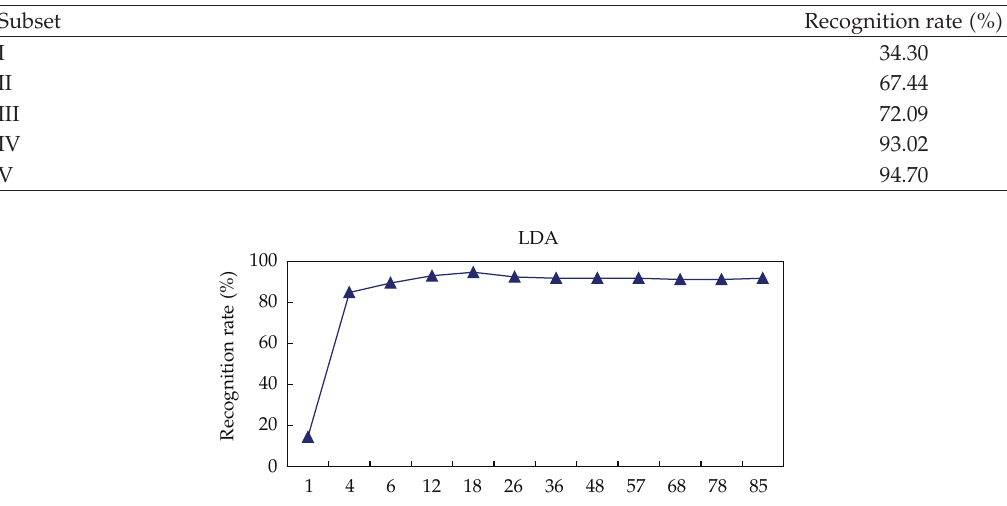
Table 3: Experimental results of LDA.